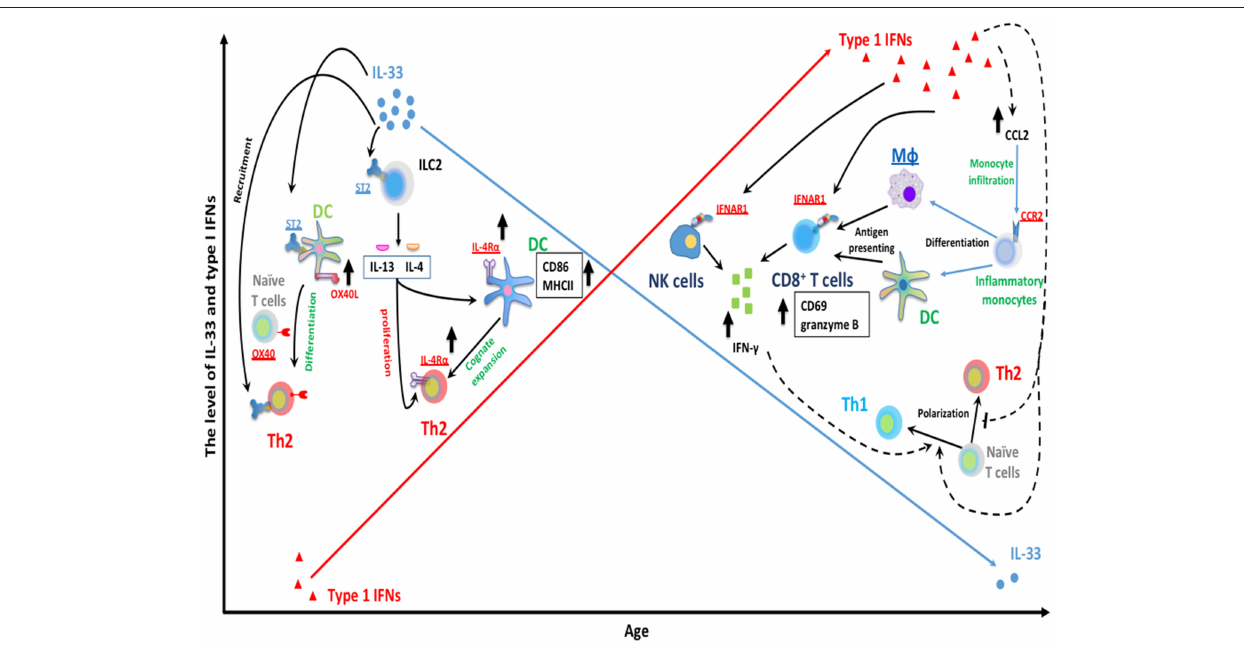
FIGURE 1 | Age-dependent differences RSV-mediated immune pathogenesis. The expression of RSV-induced IFN α is limited during infantile RSV infection and progressively increases with age. Type I IFNs are capable of suppressing Th2 development and promoting type 1 immunity. Type I IFNs have been implicated in the regulation of NK and CD8 + T cells functionality. Type I IFNs can elicit the activation of cytotoxic IFN- γ + CD8 + T cells by enhancing the recruitment of inflammatory myeloid cells into infected lungs. These infiltrating myeloid cells then differentiate into macrophage and DC, and acquire antigen presenting ability, subsequently activate CD8 + T cells and trigger CD8 + T cells IFN- γ production. In addition, type I IFNs can also act directly on CD8 + T cells and NK cells by targeting its receptor IFNAR1 on membrane of CD8 + T cells and NK cells. This results in the production of IFN γ , a key mediator for type 1 immunity, which presumably favors Th1 polarization from naïve CD4 + T cells. In contrast with IFN- α , IL-33 has been implicated in the induction of Th2-biased immune pathogenesis during neonatal RSV infection. A large amount of IL-33 is rapidly released following RSV infection in neonatal but not adult mice. IL-33 can elicit ILC2-mediated IL-13/IL-4 production through its cellular receptor ST2 on ILC2. ILC2-derived IL13/IL-4 then can facilitate cognate expansion of Th2 by upregulating the expression of Th2 costimulatory molecules (CD86 and MHCII) on DC. ILC2-derived IL-4 also promotes the proliferation of Th2 cells. It involves the upregulation of IL4R α on both DC and Th2 cells. Similarly, IL-33 can promote Th2 polarization from naïve CD4 + T cells by targeting DC via ST2 receptors on DC and then enhance the expression of OX40L on DC (ligand for cellular receptor OX40 on naïve T